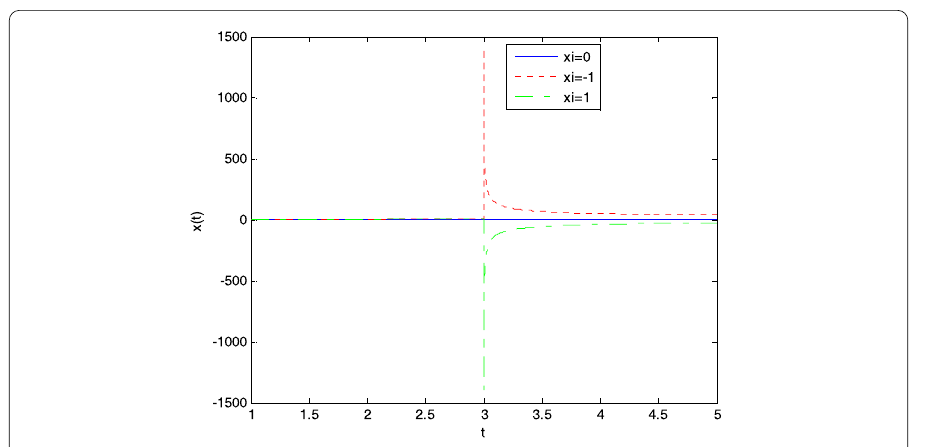
Figure 3 The solution trajectory of system (5.1) with ρ = 1